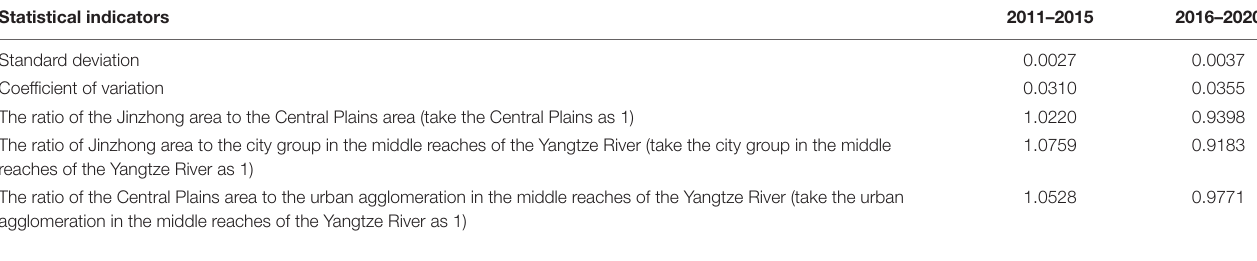
TABLE 9 | Indicators related to the gap in social development level among urban agglomerations in middle China. Statistical indicators